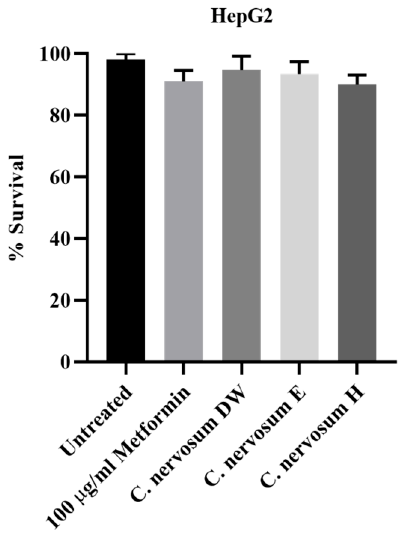
Figure 1. The cytotoxicity effect of water, ethanol, and hexane extracts of C. nervosum at concentration of 1 mg/mL on HepG2 liver cells after 72 h exposure assessed by MTT assay. Data are mean ± SD of three independent experiments. The control was cells not treated with extracts. No significant difference relative to the untreated control was noted.